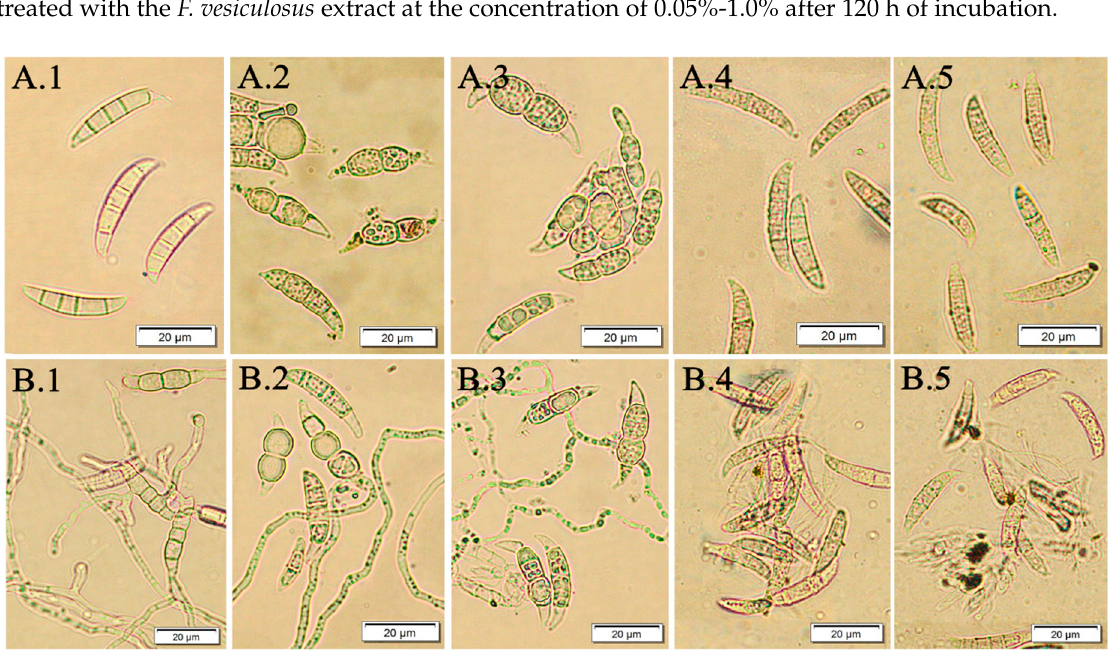
Figure 3. The effect of 100% F. vesiculosus extract on F. culmorum (CBS122 ( A ), Fc37 ( B )) and F. oxysporum (CBS129 ( C ), Fo38 ( D )) on PDA medium after 168 h of incubation.